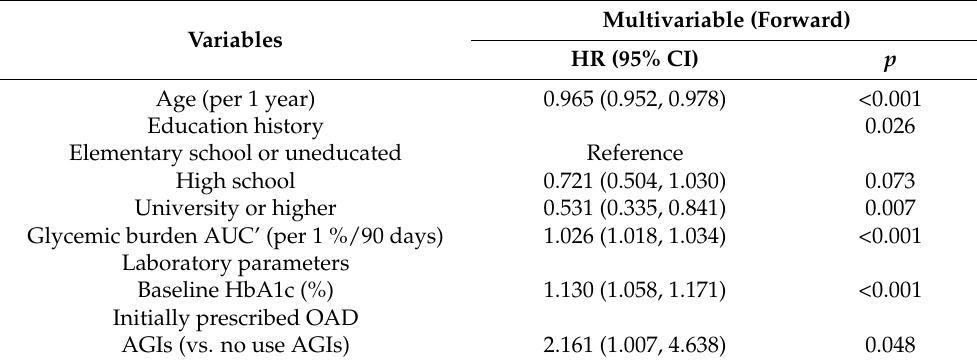
Table 3. Determinants of glycemic burden and other clinical characteristics with treatment fail- ure in initial HbA 1c > 7.0% participants ( n = 781) using multivariable forward Cox proportional hazards analysis.